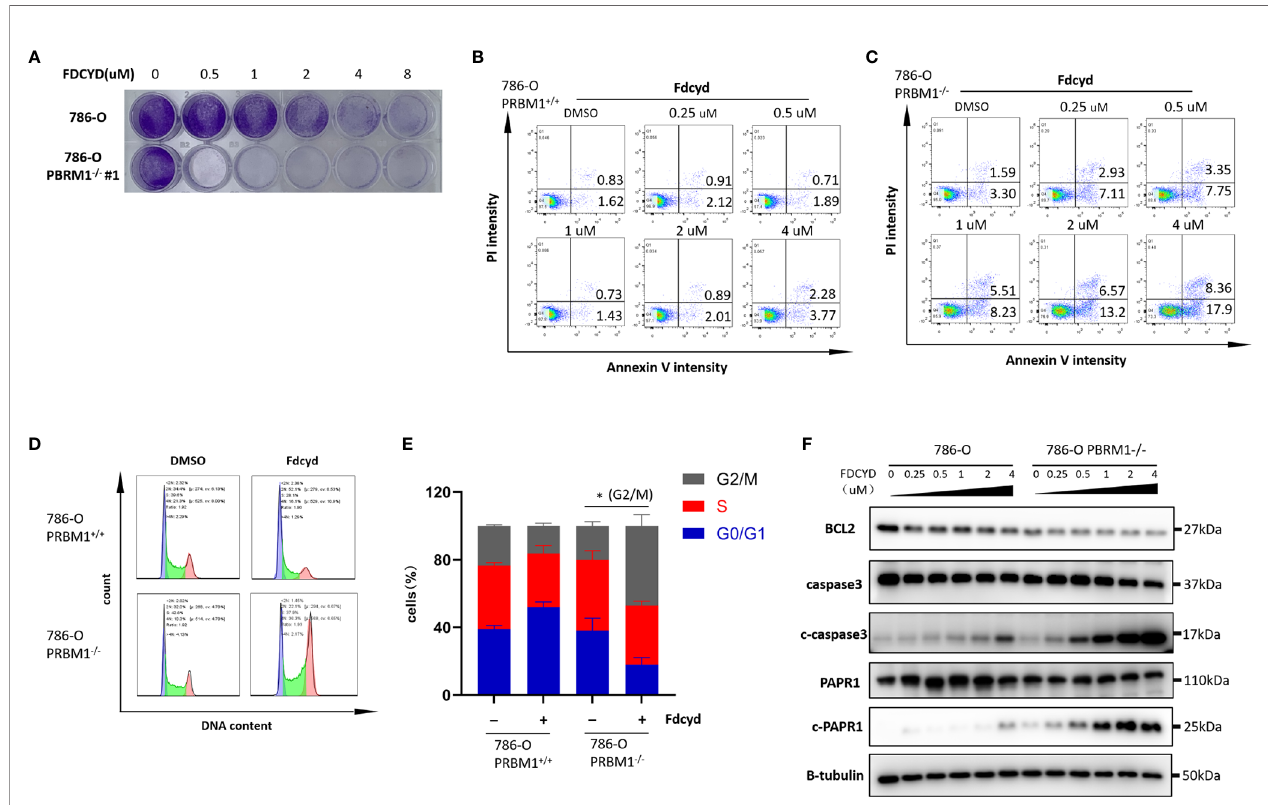
FIGURE 2 | Fdcyd induces apoptosis and G2/S cell cycle arrest selectively in PBRM1 − / − 786-O cells. (A) Colony formation assay of 786-O PBRM1+/+ and 786-O PBRM1 − / − cells treated with indicated concentrations of Fdcyd for 14 days. (B, C) Flow cytometer analysis Annexin V/PI double stained 786-O PBRM1+/+ and 786-O PBRM1 − / − cells treated with Fdcyd. (D) Flow cytometer analysis propidium iodide (PI)-stained 786-O PBRM1+/+ and 786-O PBRM1 − / − cells treated with Fdcyd. (E) Percentage of cell populations in G1, S, and G2/M phase from the fl ow cytometry analysis. (F) Immunoblot analysis of BCL2, PARP1 and caspase-3. The cleavage of PARP1 and caspase-3 was shown as markers of apoptosis induction. Data are mean ± SD of three independent experiments. *P < 0.05, student ’ s t